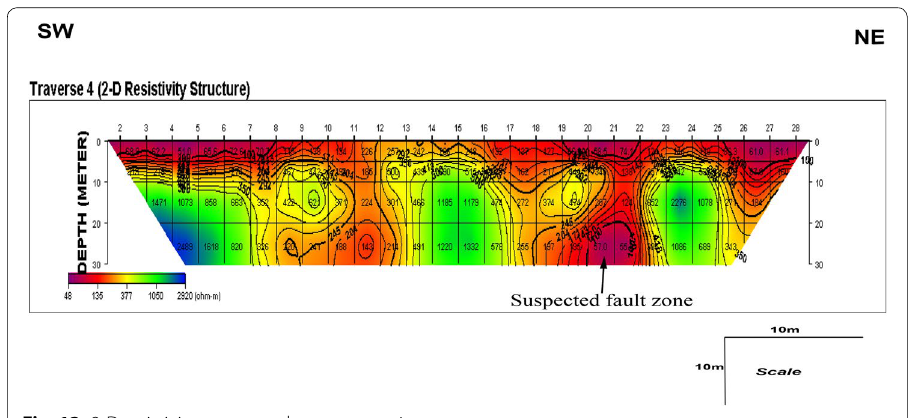
Fig. 13 2-D resistivity structure along traverse